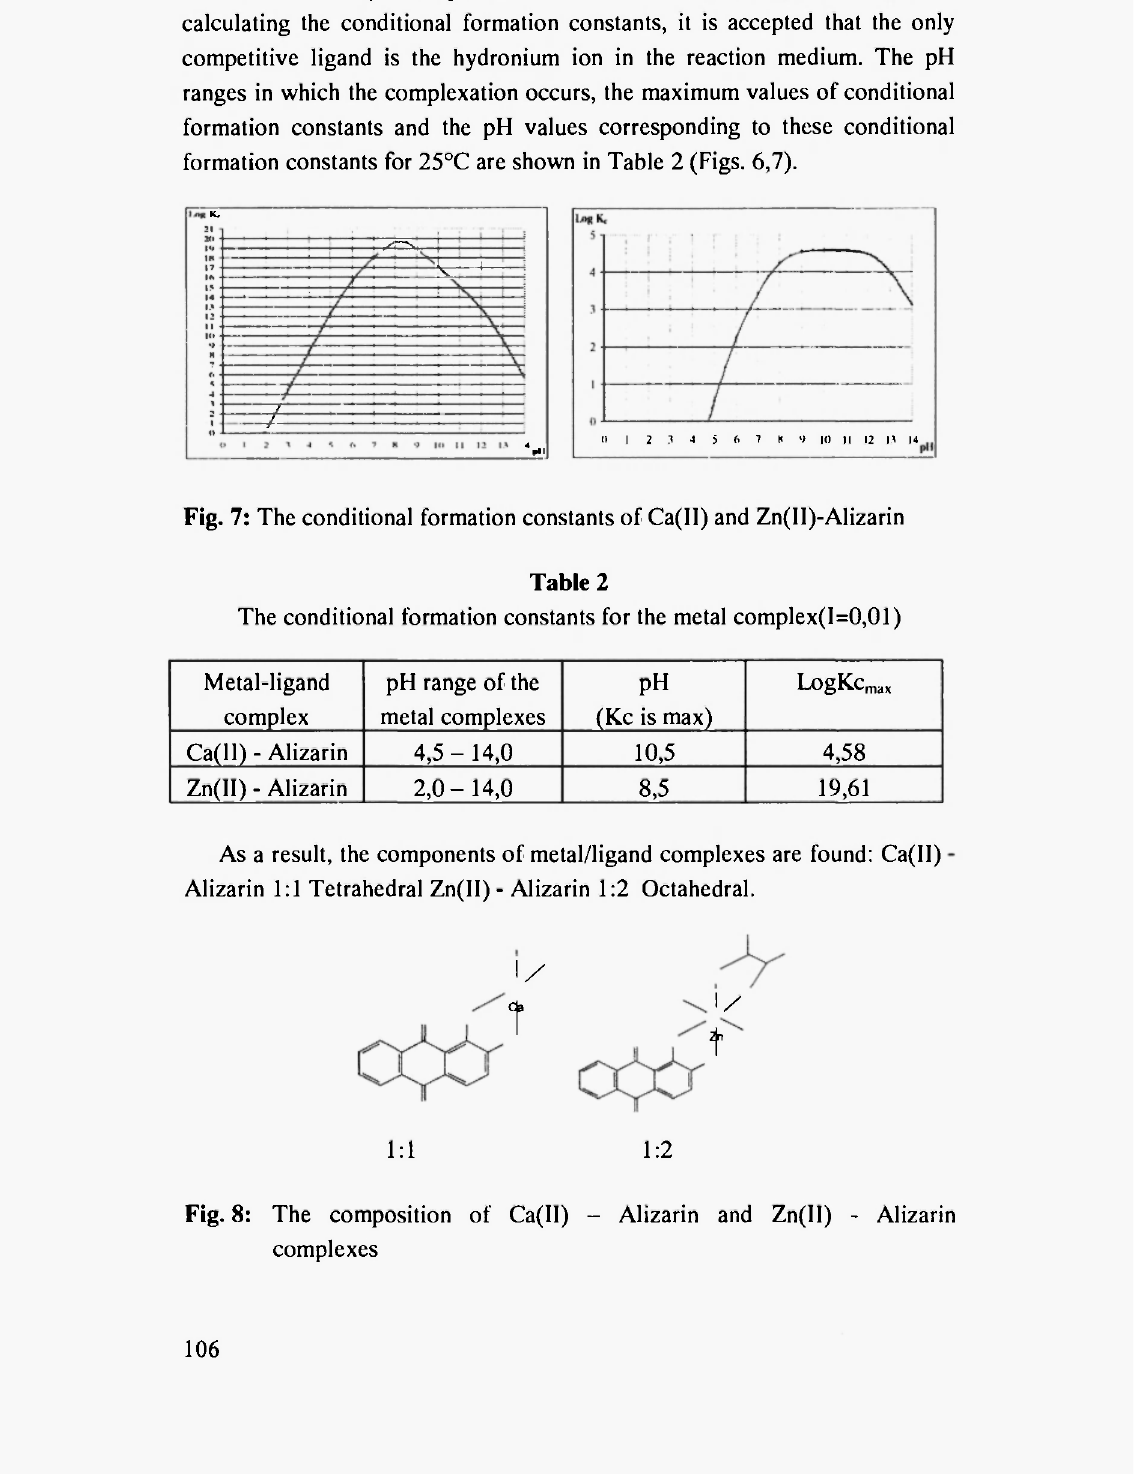
The composition of Ca(II) - Alizarin and Zn(II) - Alizarin